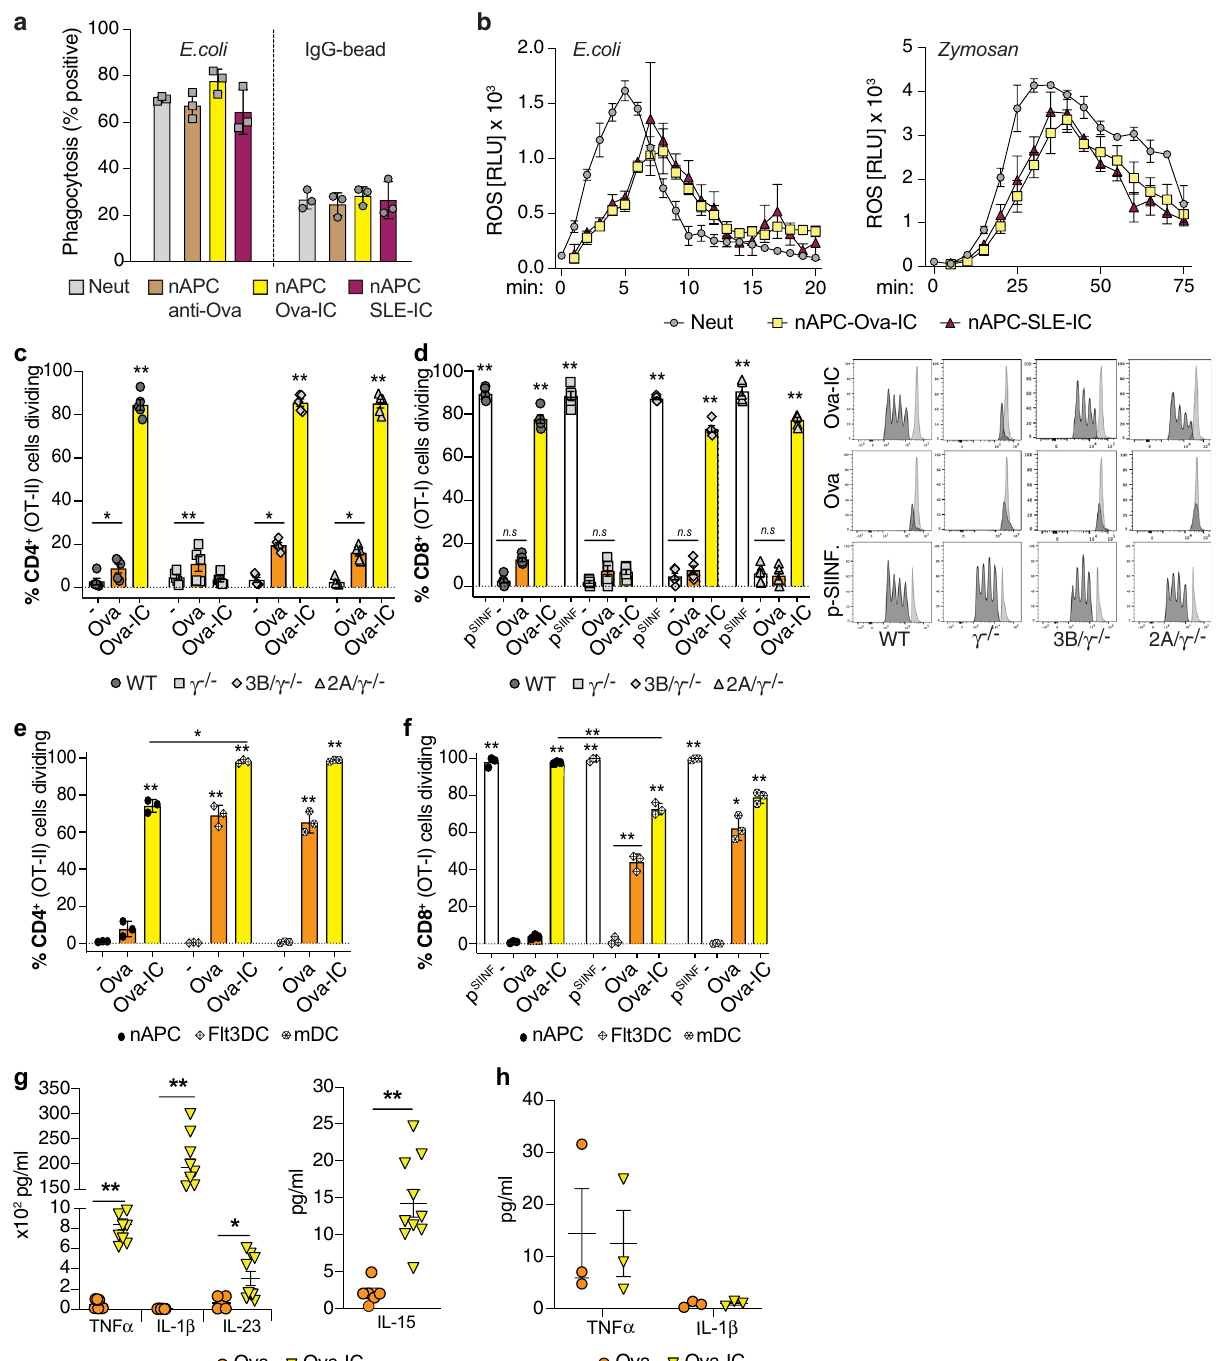
NATURE COMMUNICATIONS| (2021) 12:4791